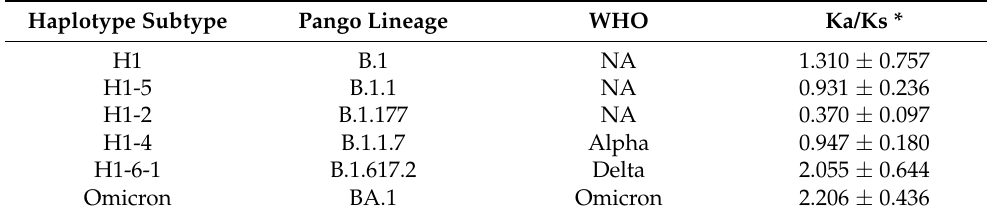
Table 1. The Ka/Ks of some major haplotype